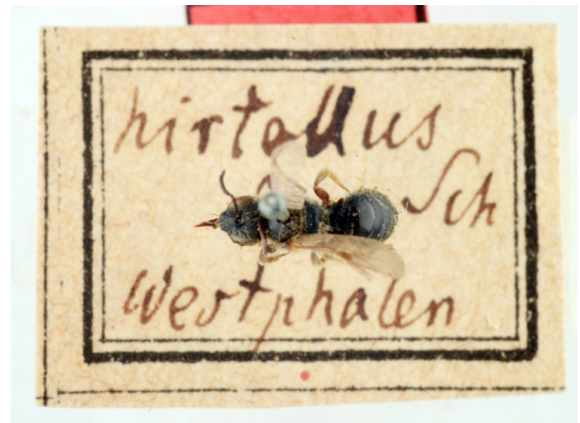
Fig. 5. Halictus hirtellus Schenck, 1896, lectotype,